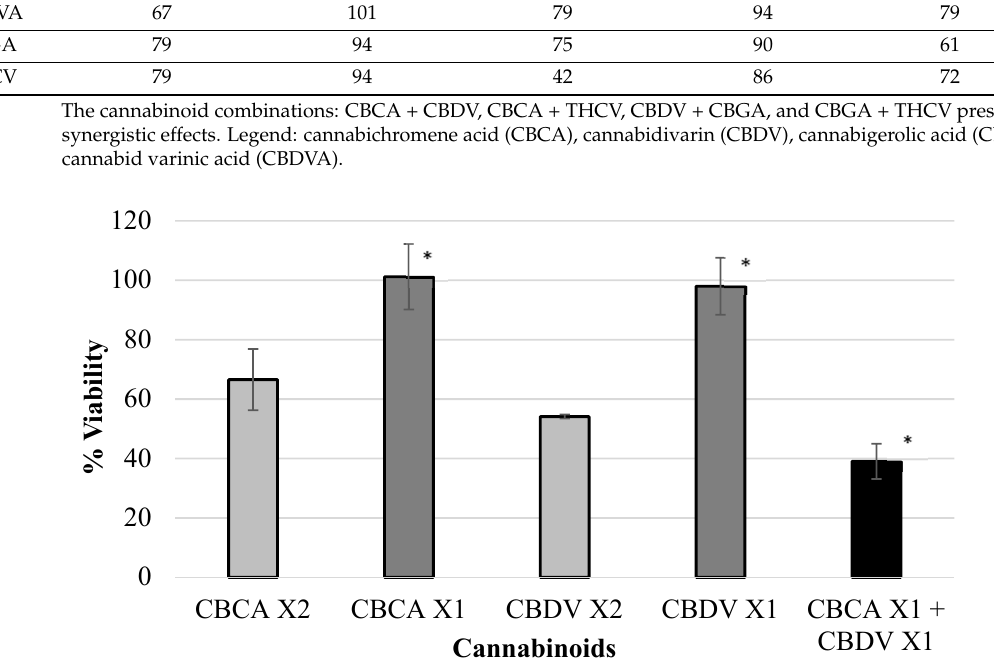
Table 3. The effect of combinations of cannabinoids on polyp cells’ viability.